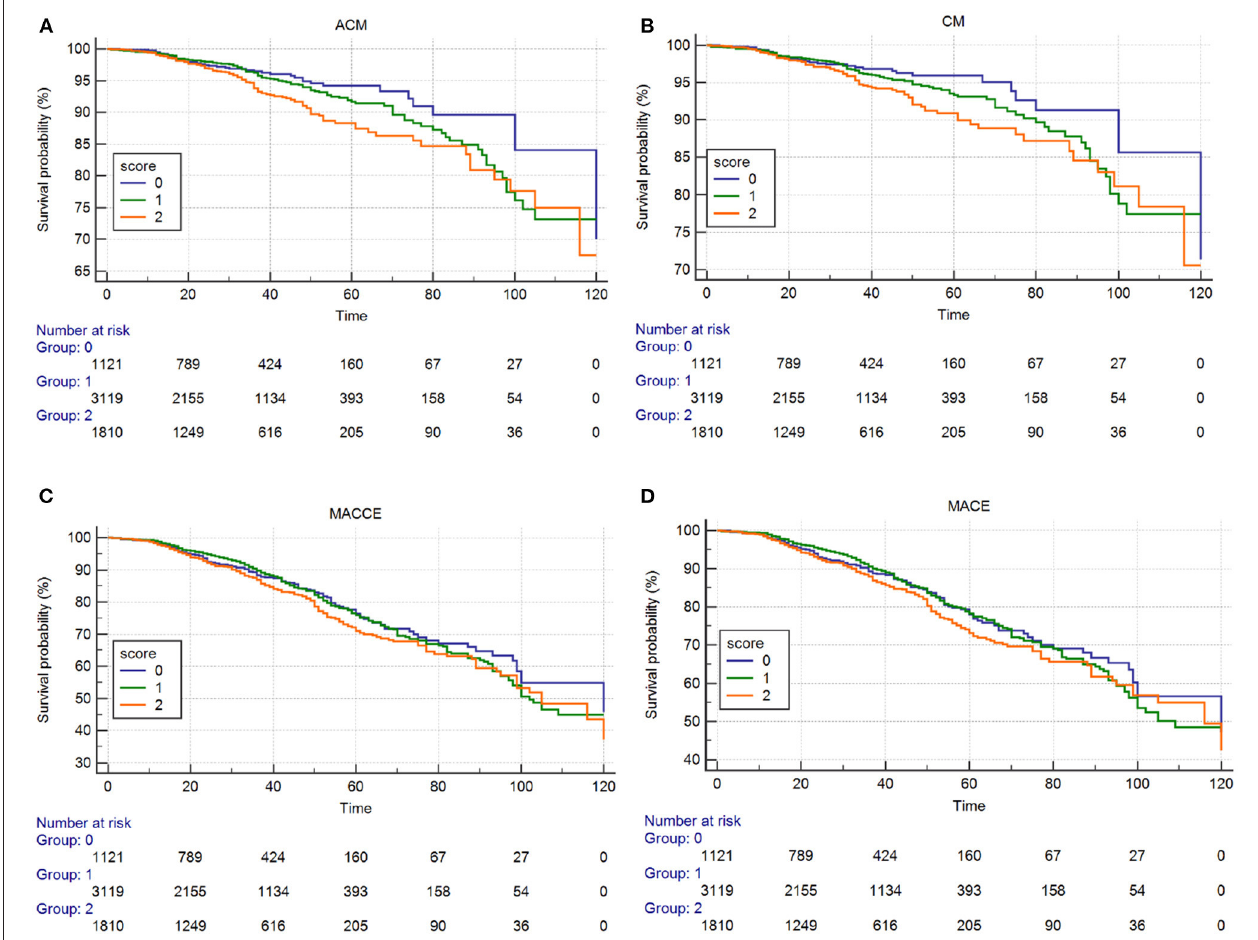
FIGURE 2 | Cumulative Kaplan–Meier estimates of the time to the first adjudicated occurrence of primary endpoint and secondary endpoints. (A) ACM; (B) CM; (C) MACCEs; (D)